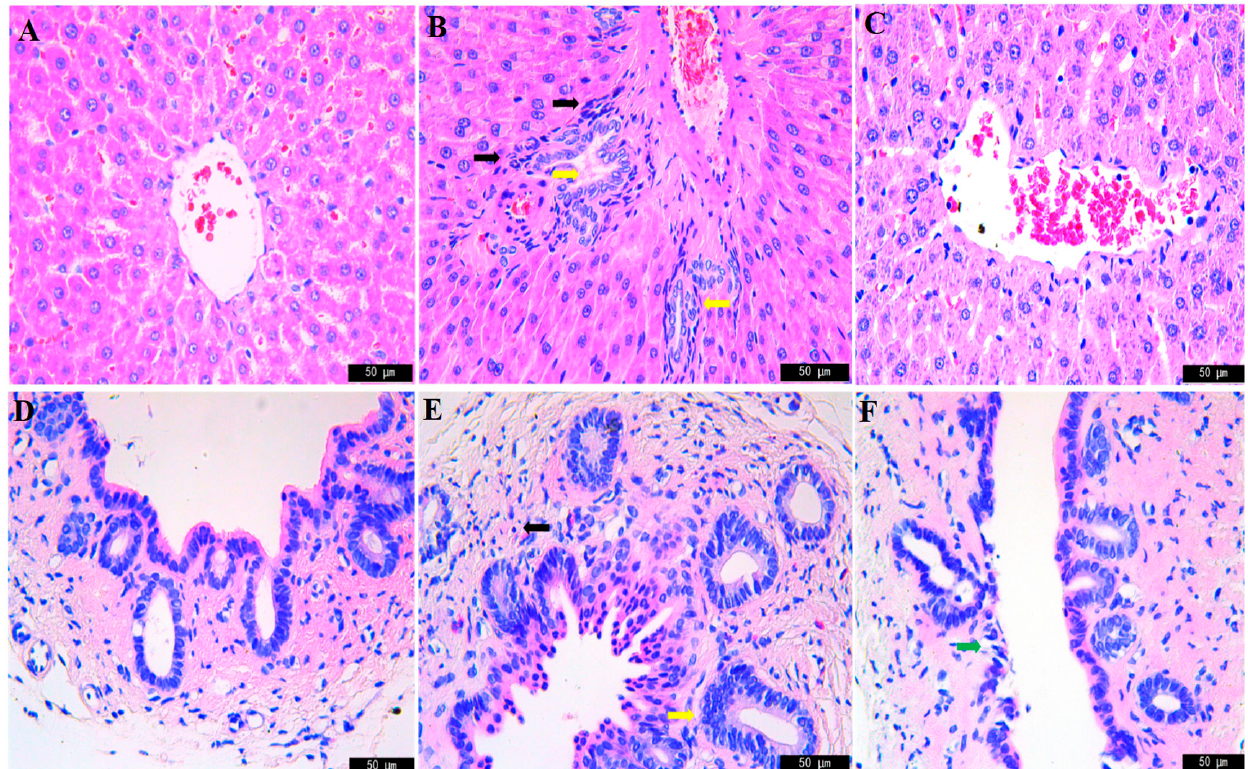
Figure 1. HE staining results of liver and bile duct with microscope (×400). ( A – C ): liver tissue, ( D – F ): bile duct tissue, ( A , D ): control group, ( B , E ): model group, ( C , F ): JGCC group. Black arrow: inflammatory cells, yellow arrow: hyperplasia of bile duct and bile duct epithelium, green arrow: degeneration and necrosis of bile duct epithelial cells.